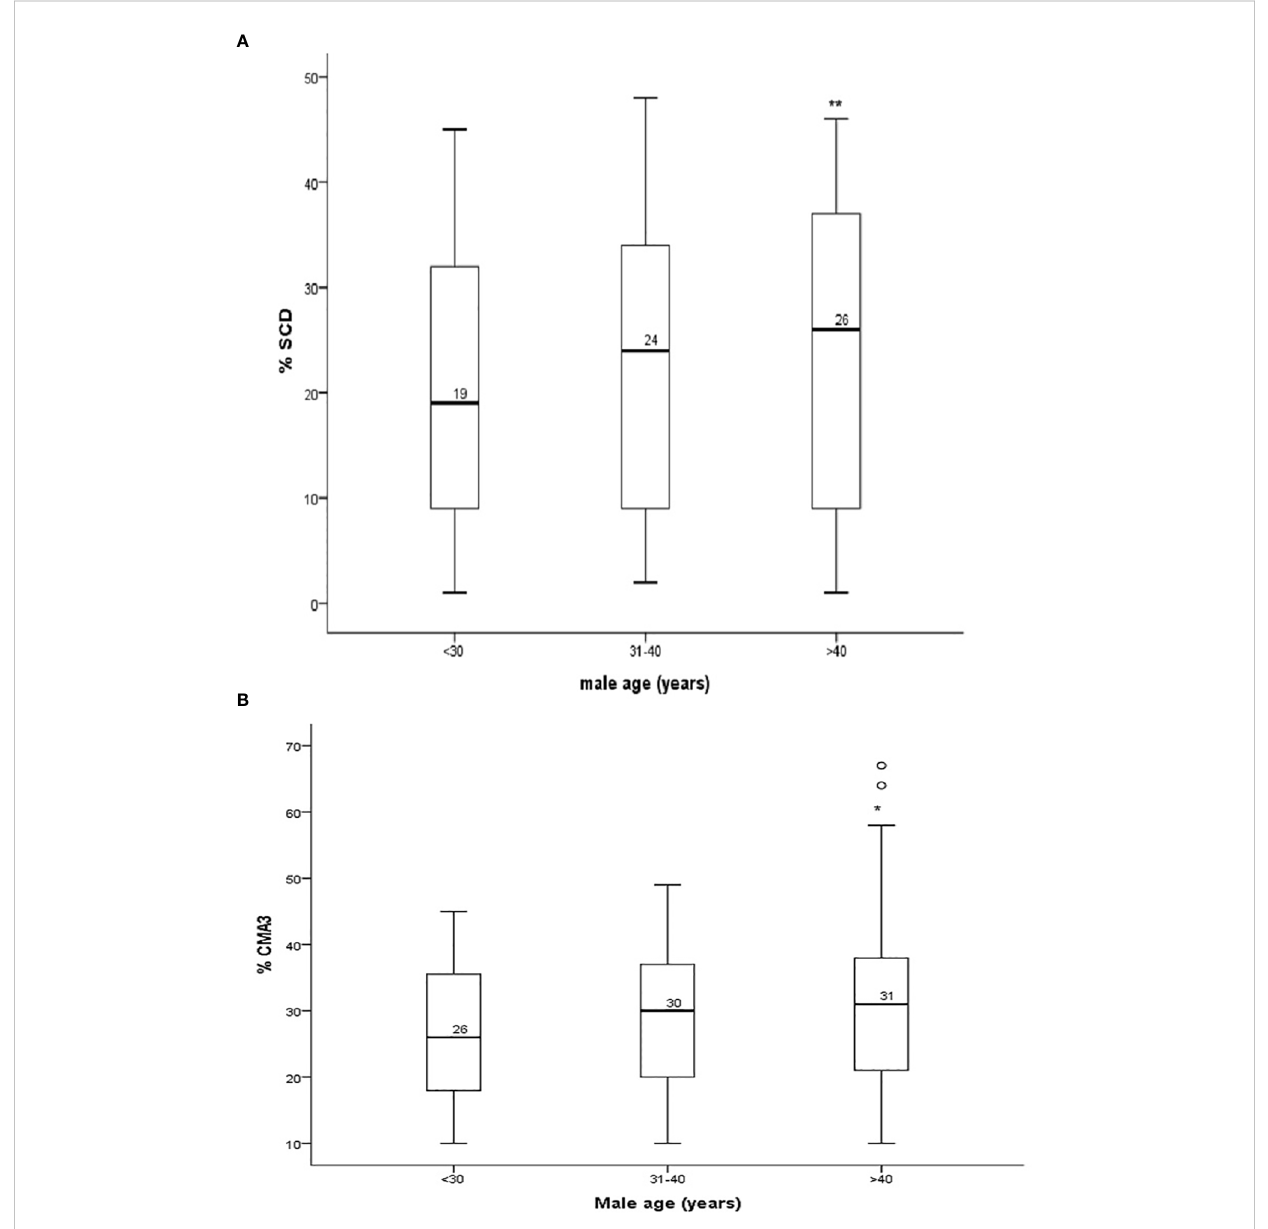
FIGURE 1 (A) Percentage of sperm chromatin dispersion (SCD) and (B) sperm protamine (CMA3+) content in sperm of males in different age groups. *P < 0.05, **P < 0.01.